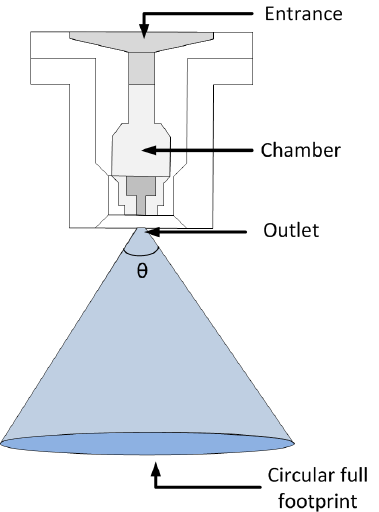
Figure 5. Full cone nozzle (adapted from the Magnojet ®